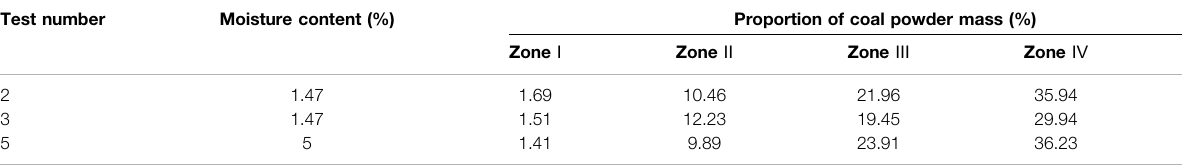
TABLE 3 | Distribution of outburst coal powder in different zones.